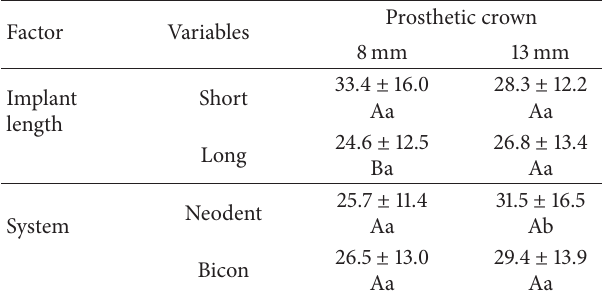
Table 4: Comparison of the study factors implant length and implant system relative to the crown height under axial loading in MPa.